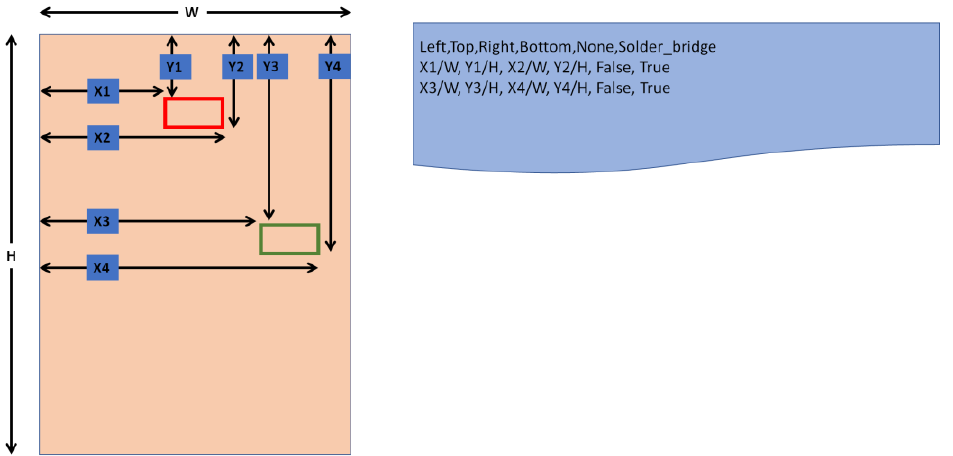
Figure 3. Method for writing annotation file (on the right side) for a PCBA image file (on the left side) with dimensions W x H and 2 soldering bridge faults represented in red and green bounding